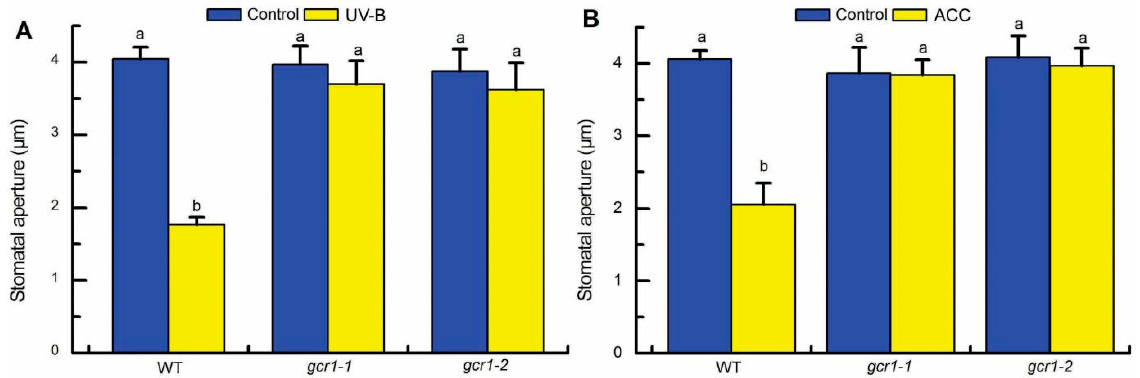
Figure 1. GCR1 plays a positive role in UV-B and ethylene induction of stomatal closure. ( A ) Leaves of the wild-type Col-0 (WT) and gcr1 mutants with open stomata were exposed to light alone (Control) or with 0.5 W/m 2 UV-B (UV-B) for 3 h. ( B ) Leaves of the WT and gcr1 mutants with open stomata were incubated in MES buffer alone (Control) or containing 100 μ mol/L ACC (ACC) for 3 h under the light. After treatments, stomatal apertures were measured in epidermal strips taken from the abaxial surfaces of the treated leaves. Data are presented as means ± SE of three independent experiments, each with 30 stomata. Means with different letters are significantly different at p < 0.01.